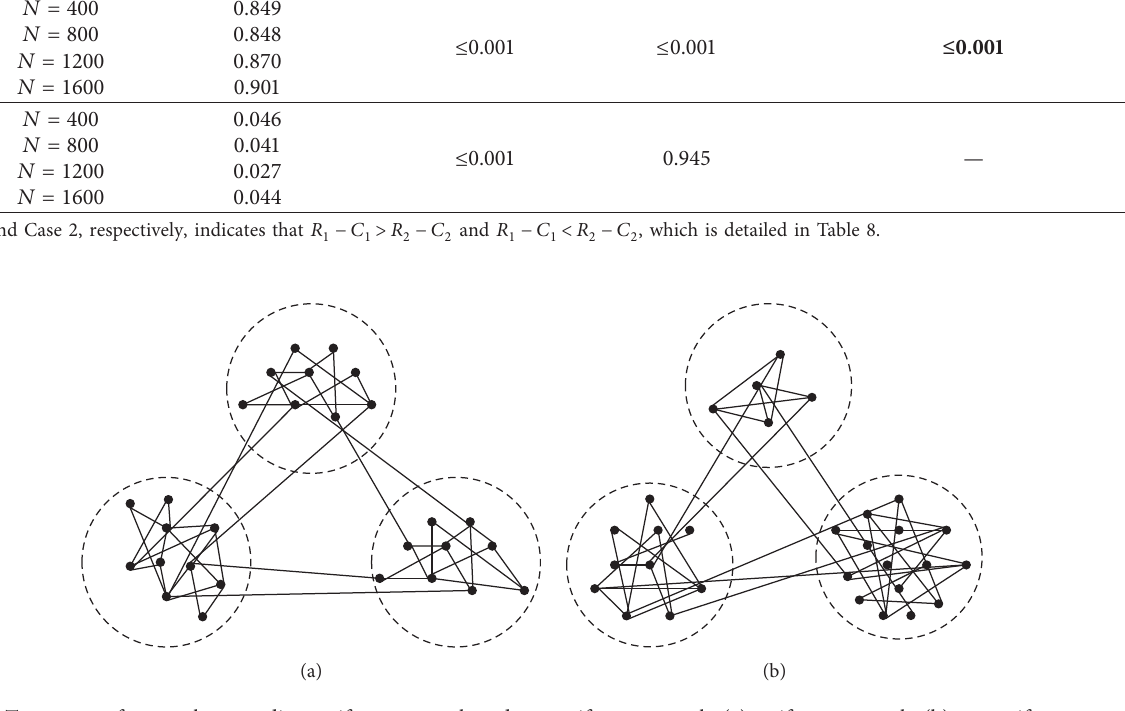
Figure 9: Two types of networks regarding uniform network and nonuniform network, (a) uniform network, (b) nonuniform